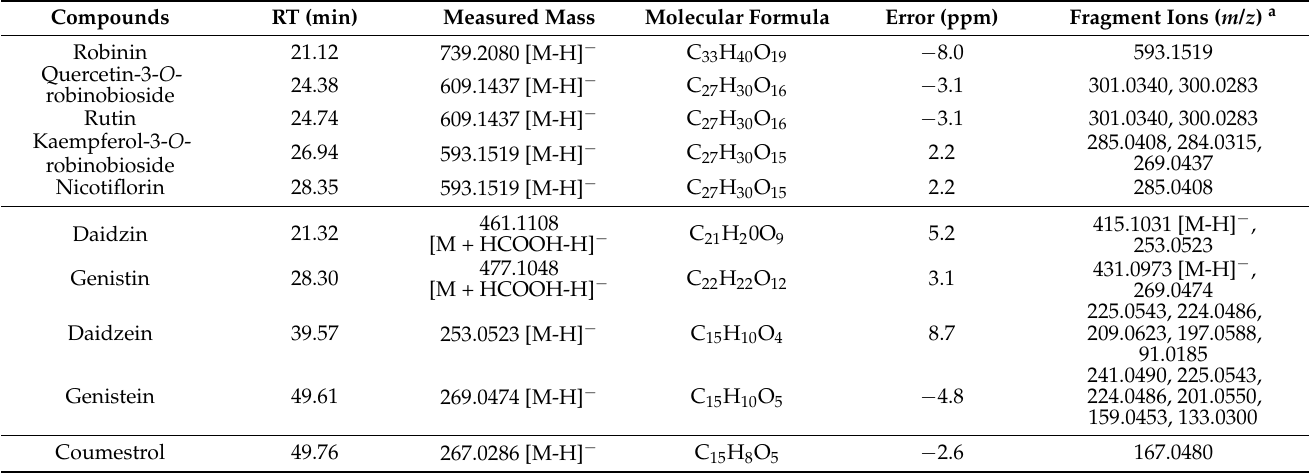
Table 1. Identification of phytochemicals present in the PL-L-70E by HPLC–Q-TOF–MS e in negative ion mode.